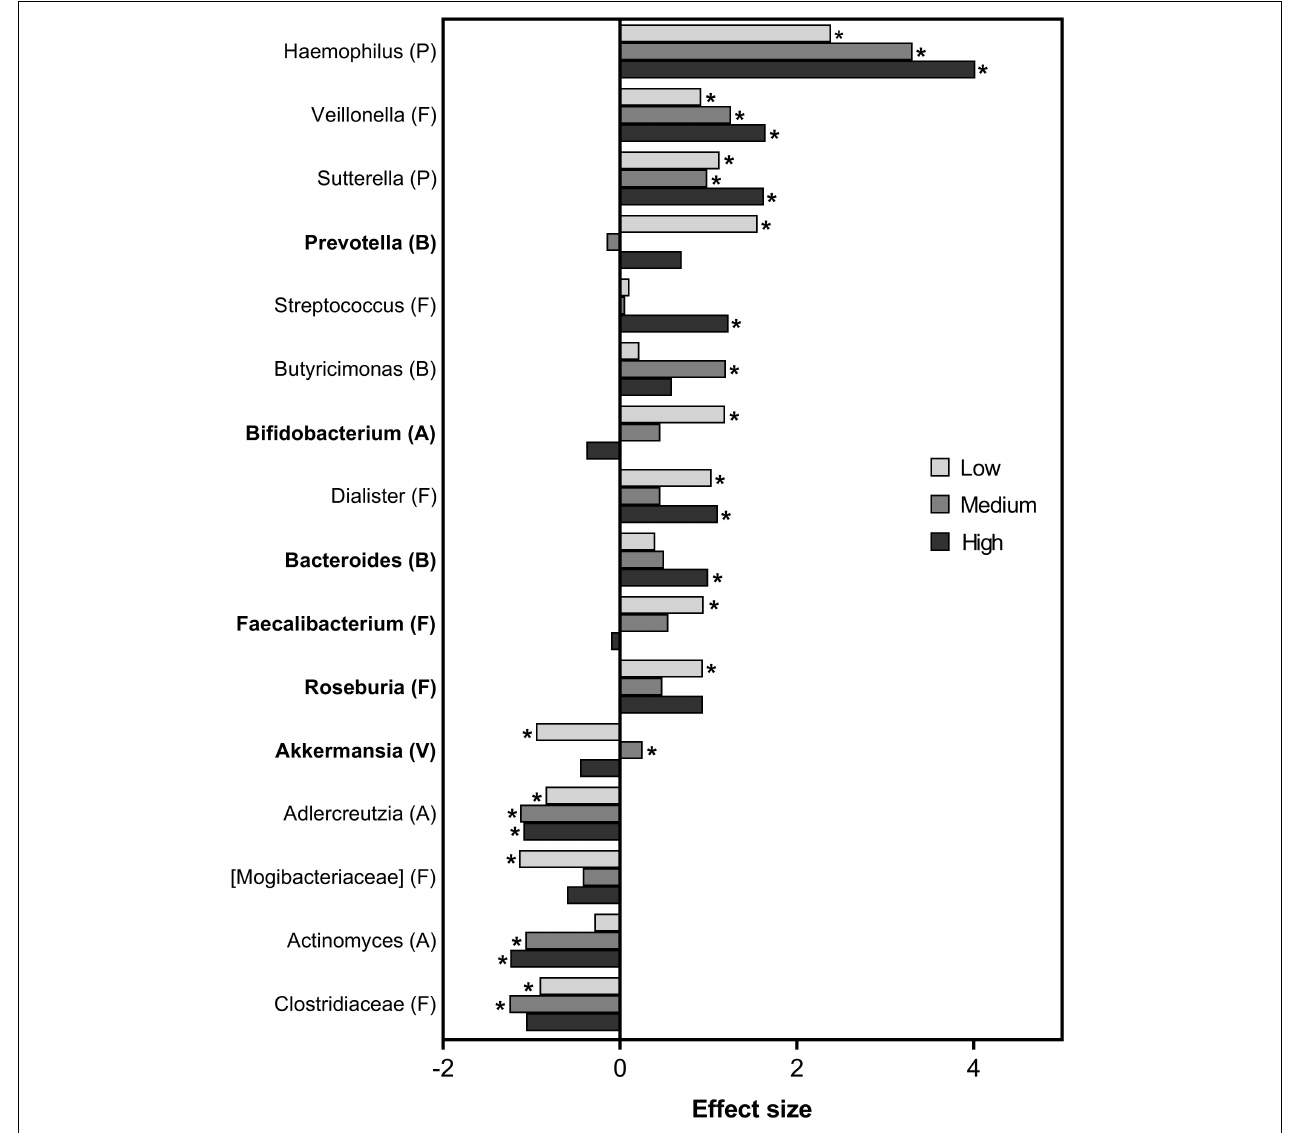
FIGURE 8 | Bacterial taxa after intake of granola with cereal beta-glucan. The taxa order is sorted from high to low effect size independent on test meal. The effect sizes were calculated as the difference in log ratio group means of test meals vs representative baseline after adjusting for individual differences. Asterisk indicates significant relationship (VIP > 1). Bars are colored according to dose of beta-glucan. Dominating genera (average abundance > 1%) are indicated in bold. Phyla are indicated within parentheses, A: Actinobacteria, B: Bacteroidetes, F: Firmicutes, P: Proteobacteria, V: